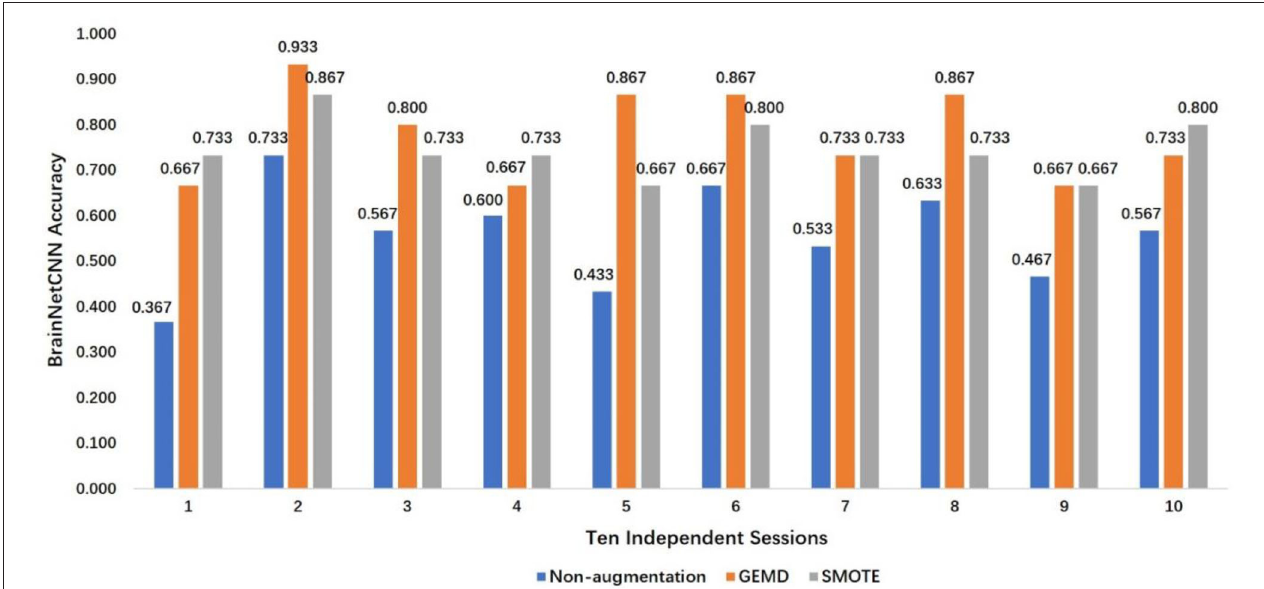
FIGURE 7 | Best accuracy using GEMD, SMOTE, and non-augmented case in 10 independent sessions.